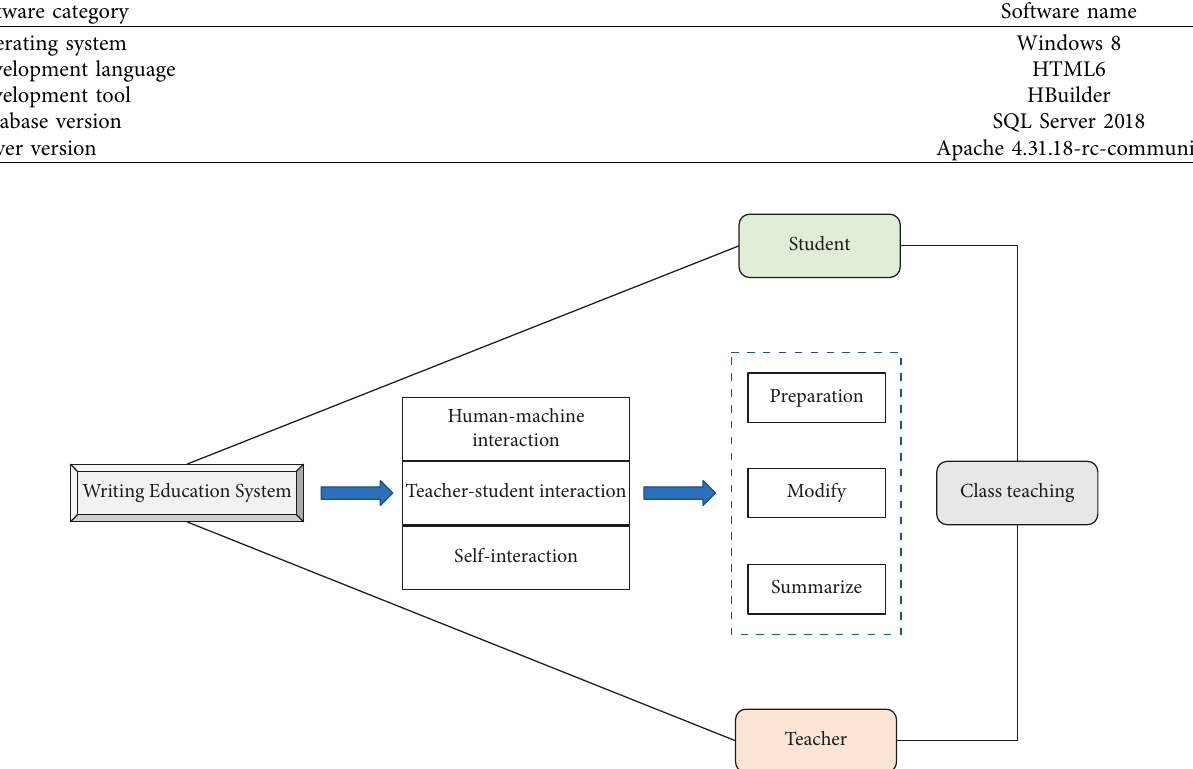
Figure 3: Process of the multicomponent writing instructional